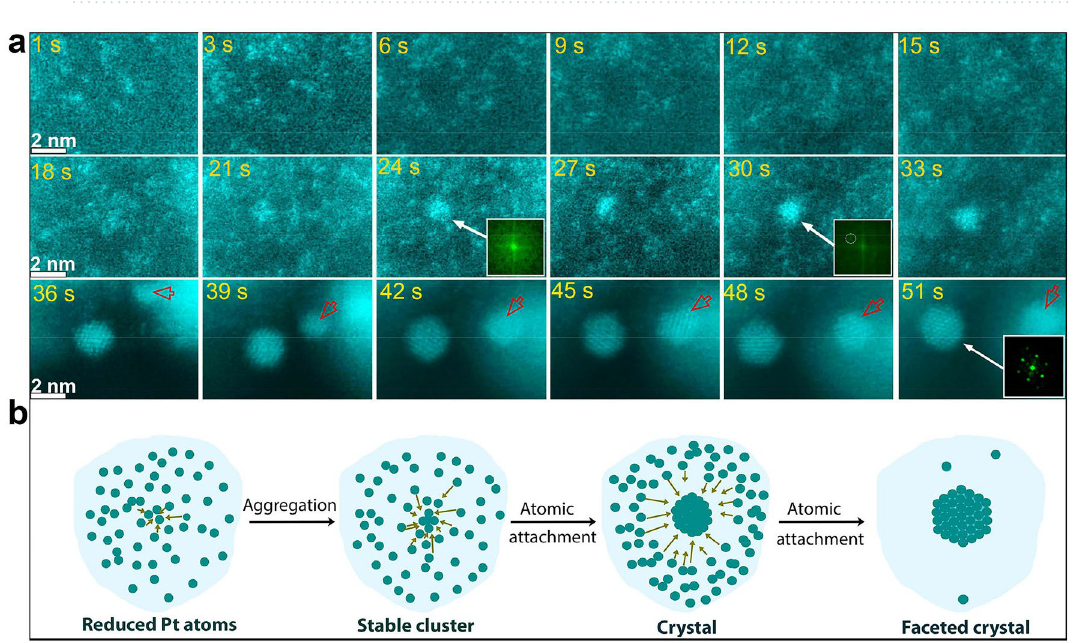
Figure 2. Nucleation and growth of nanoparticles via a two-step nucleation mechanism, followed by atom-by- atom attachment. ( a ) Image sequences from Movie S3 showing the nucleation and growth of Pt nanoparticle via atom-by-atom growth, where atoms migrate through the liquid to attach to an initially formed cluster. At the end of the series, a single crystal of about 2 nm diameter is formed. ( b ) Schematic illustration of the first growth stage via atom-by-atom nucleation and growth. Images are shown in false